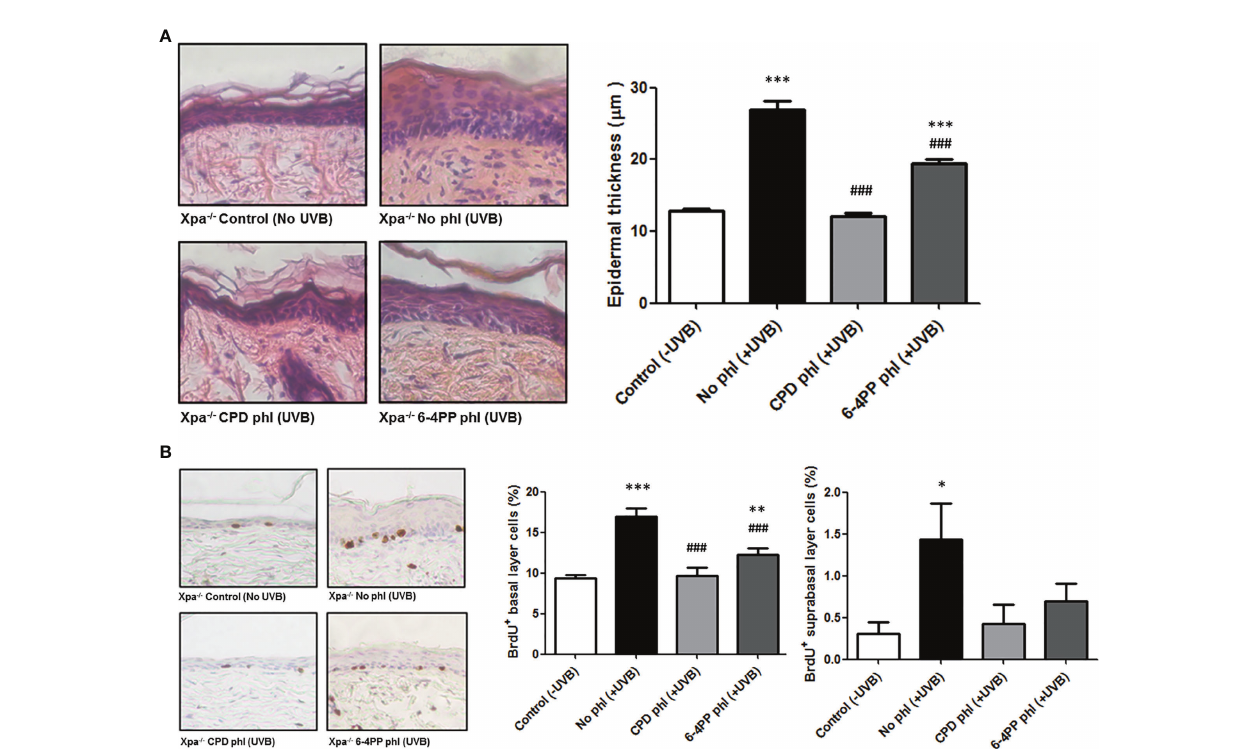
FIGURE 1 | CPD removal in keratinocytes abrogates UV-induced hyperplasia and cell proliferation, while 6-4PP removal decreases these effects in Xpa-/- mice. (A) Epidermal thickness of Xpa-/- mice daily irradiated or not with UVB (20 J/m2) followed by photoreactivation of CPD- or 6-4PP-Photolyase (phl) for 30 consecutive days. Quantitative analysis of epidermal thickness was performed by perpendicular measurements of the tissue extension in skin sections stained with H&E (n = 4), with representative images (40x) shown. (B) Quanti fi cation of cell proliferation in the basal and suprabasal layers of chronically UV-irradiated Xpa-/- mice, with representative images (40x). Tissues were stained for BrdU+ cells by immunohistochemistry counterstained with hematoxylin (n = 4). Asterisks (*) indicate a statistically signi fi cant difference between the designated group and the negative, Xpa-/- non-irradiated, controls, while the pound signs (#) indicate a signi fi cant difference between the designated group and the positive control group, Xpa-/- mice with no photolyase UVB-irradiated. “ * ” or “ # ” : p<0.05, “ ** ” or “ ## ” : p<0.01, and “ *** ” or “ ### ” : p<0.001.